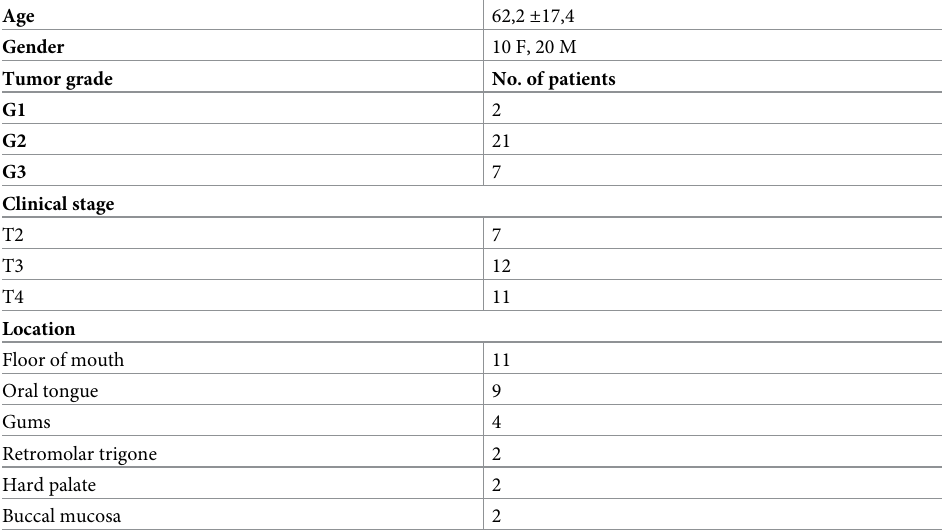
Table 1. Characteristics of 30 patients surgically treated due to oral cancer, including tumor